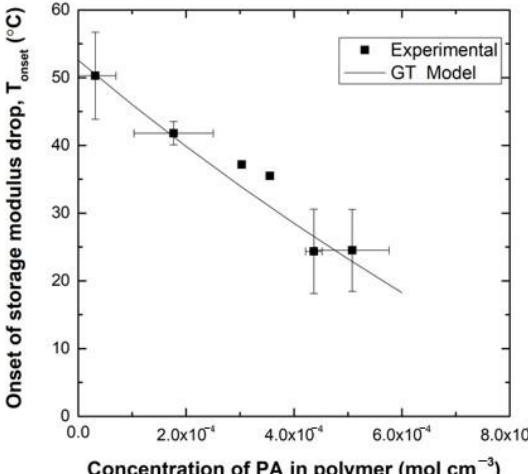
Figure 8. Temperature of the extrapolated onset of the storage modulus change ( ◦ C), T onset , of DMA specimen with varying concentrations of PA in polymer (M). Data shows that with increasing mass uptake of solvent, T onset